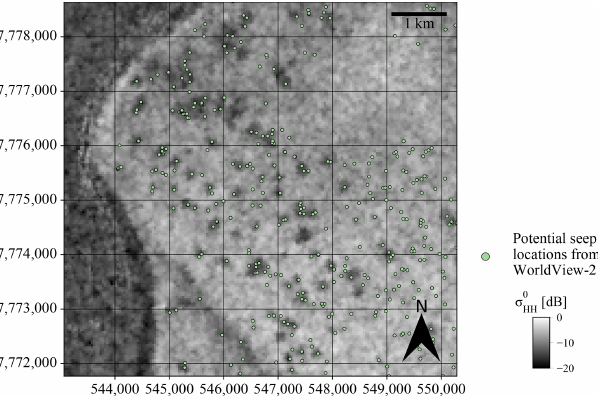
Figure 9. Comparison of detected holes (potential seep locations, green dots) from WorldView-2 imagery acquired on 22 May 2016 on top of the HH-polarisation band of a Sentinel-1 scene acquired on 7 April 2016 showing backscatter anomalies at an early stage of development. CRS: WGS 84 / UTM zone